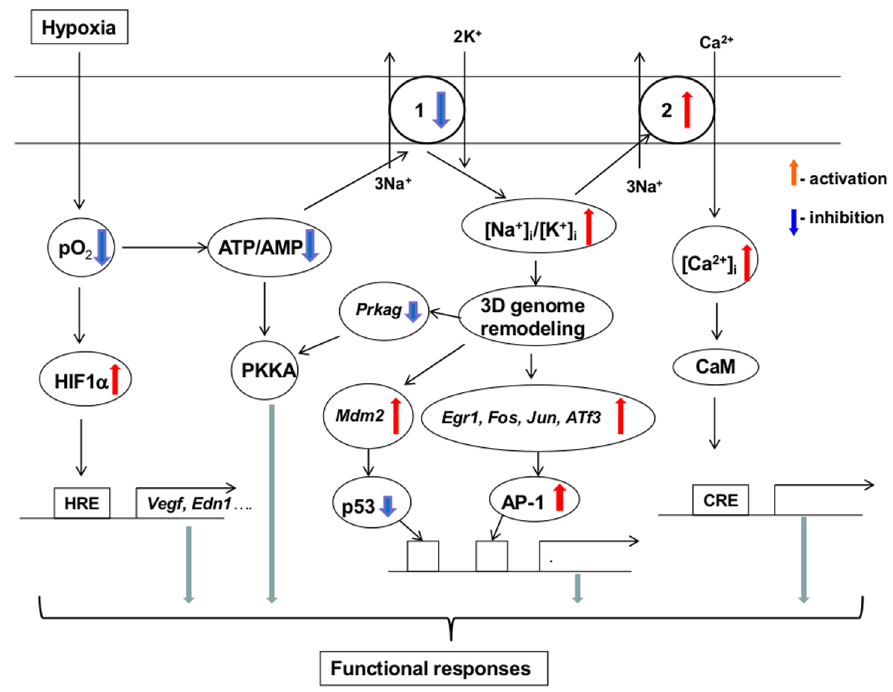
Figure 10. Possible mechanisms of the involvement of elevated [Na + ] i /[K + ] i ratio in the transcriptomic changes evoked by hypoxia: aworkinghypothesis . 1– Na + ,K + -ATPase; 2– Na + /Ca 2 + exchanger; CaM – calmodulin; CRE – Ca 2 + -response elements. For other abbreviations, see